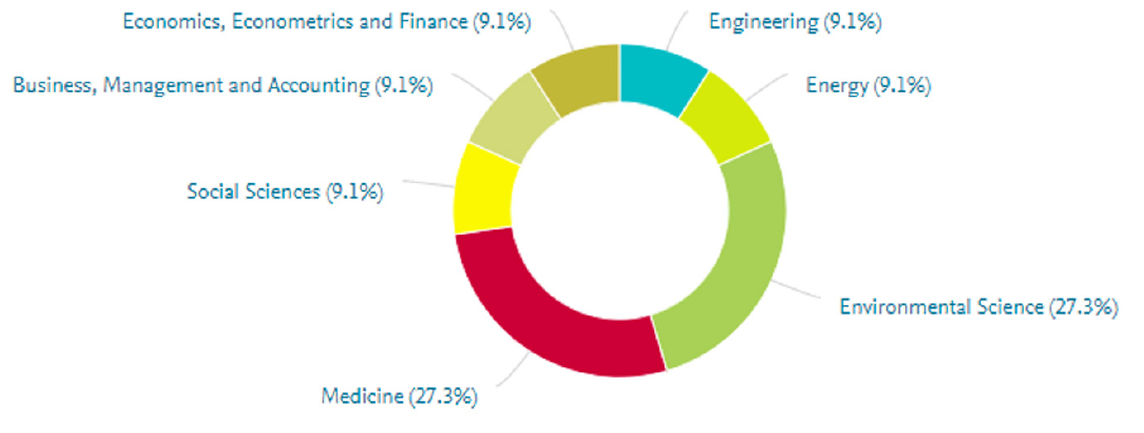
Figure A3. Structural analysis by subjects for “SDG 3 and responsible